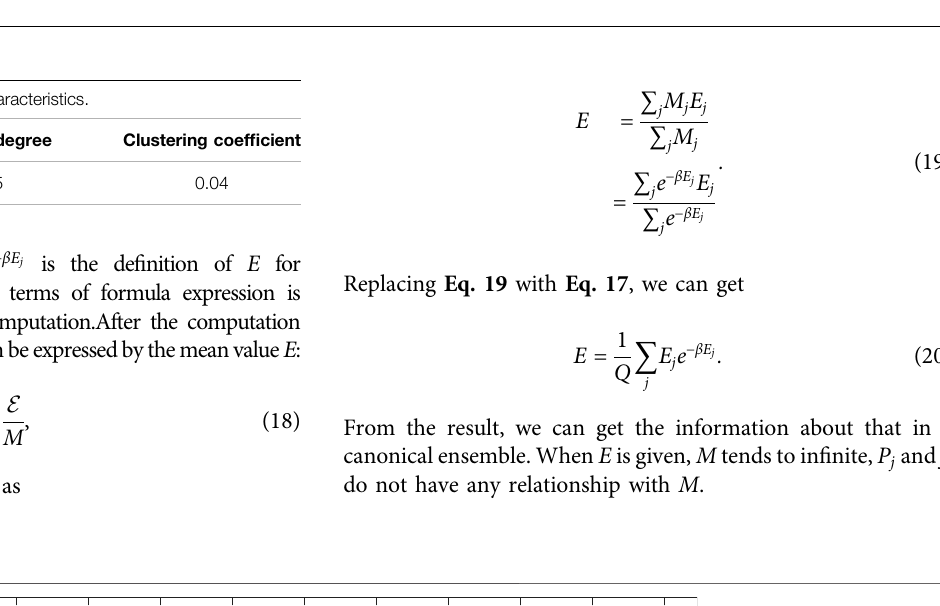
FIGURE 2 | Cells of the system ( 31 ) . The state change in the system (31), and the distribution of these states of combination. (A) Node ’ s states change, and there are four states in these cells; (B) the relation of 100 cells, and these cells were randomly generated; (C) main result of the system (31): the distribution of these states of combination.